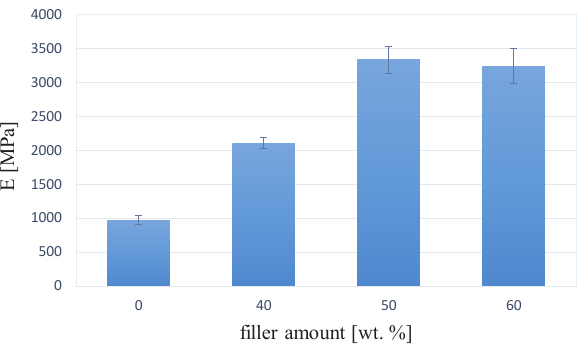
Figure 2: The influence of filler amount on Young’s modulus (E) of neat resin and composite filled with 40, 50 or 60 wt. % silanized silica; photopolymerization conditions - 20 second/1 mm material thickness, the power of light curing unit 1400 mW/cm 2 .